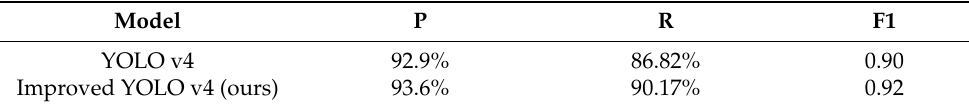
Table 1. Test set experiment results; conf-thresh = 0.5; IOU = 0.5.